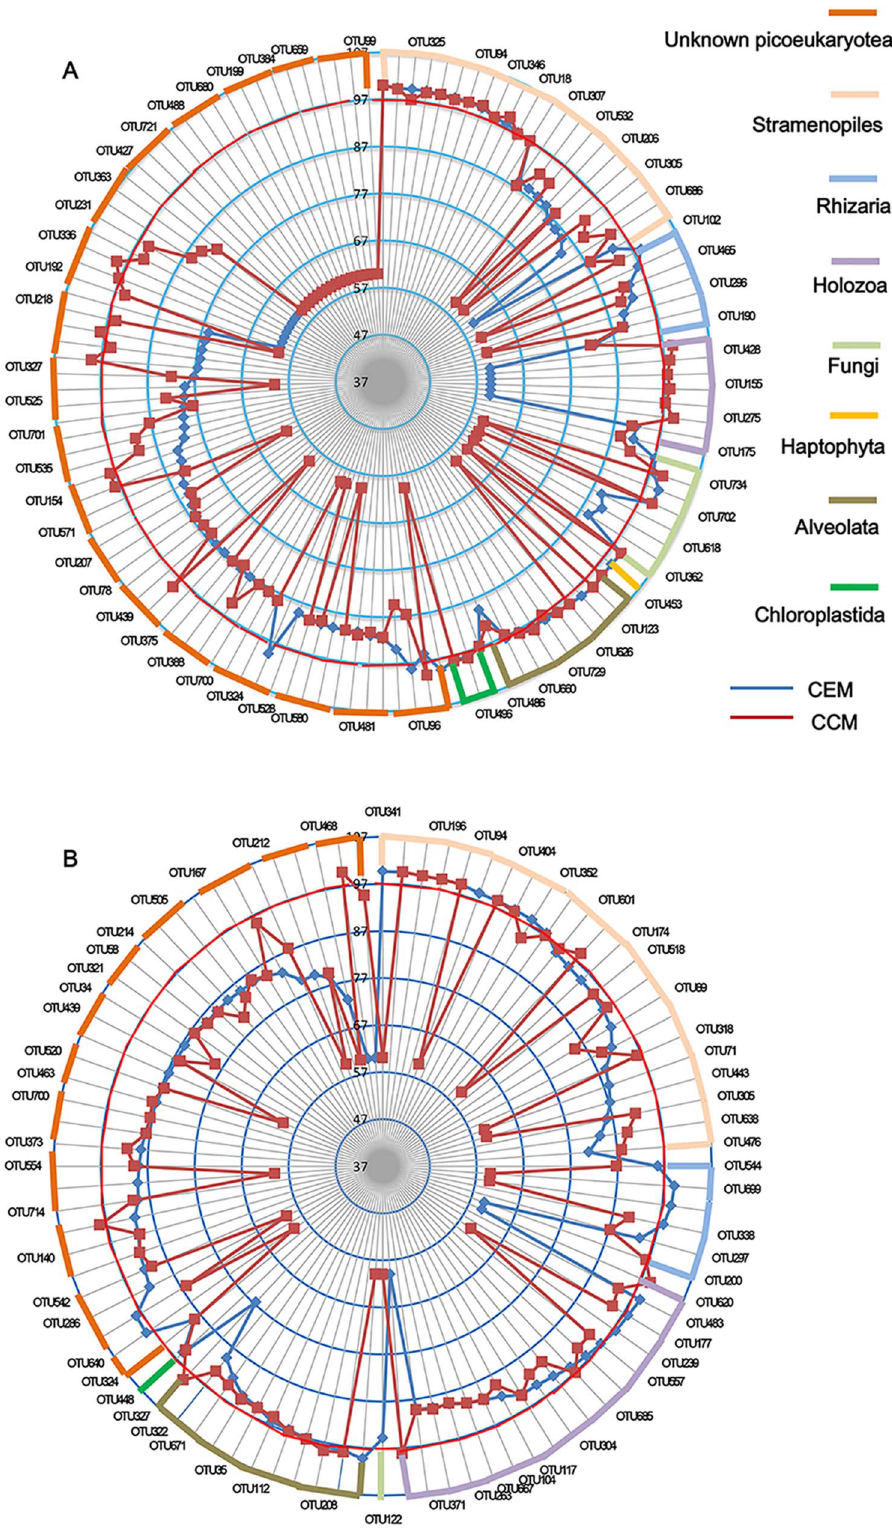
Figure 6. Novelty pattern plot for the different eukaryal classes found in mesosaline lake and hypersaline lake. (A) mesosaline saline, (B) hypersaline. Closest environmental match (CEM) and the closest cultured match (CCM) available in GenBank (BLAST search, May 2014). Dots below 61% similarity in both axes indicated no similarity sequences.